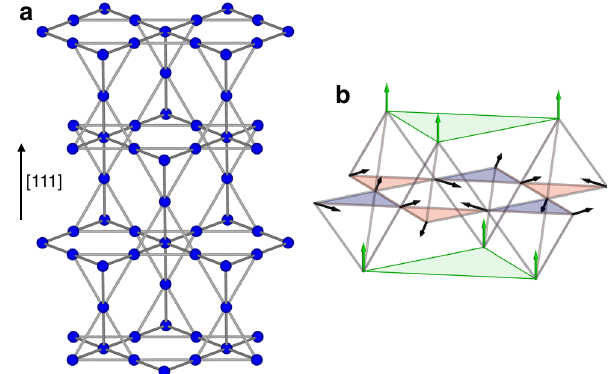
Fig. 1 Kagome ice state in the pyrochlore lattice. a View of the pyrochlore structure along the [111] direction showing the stacking of triangular and kagome planes (see also Supplementary Table 1 and Supplementary Figure 1). b Classical kagome ice state when a magnetic fi eld is applied along [111]. The apical spins in the triangular planes (green triangles) are parallel to the fi eld, while the kagome spins obey the ice-rule 2 in − 1 out (red triangles)/1 in − 2 out (blue